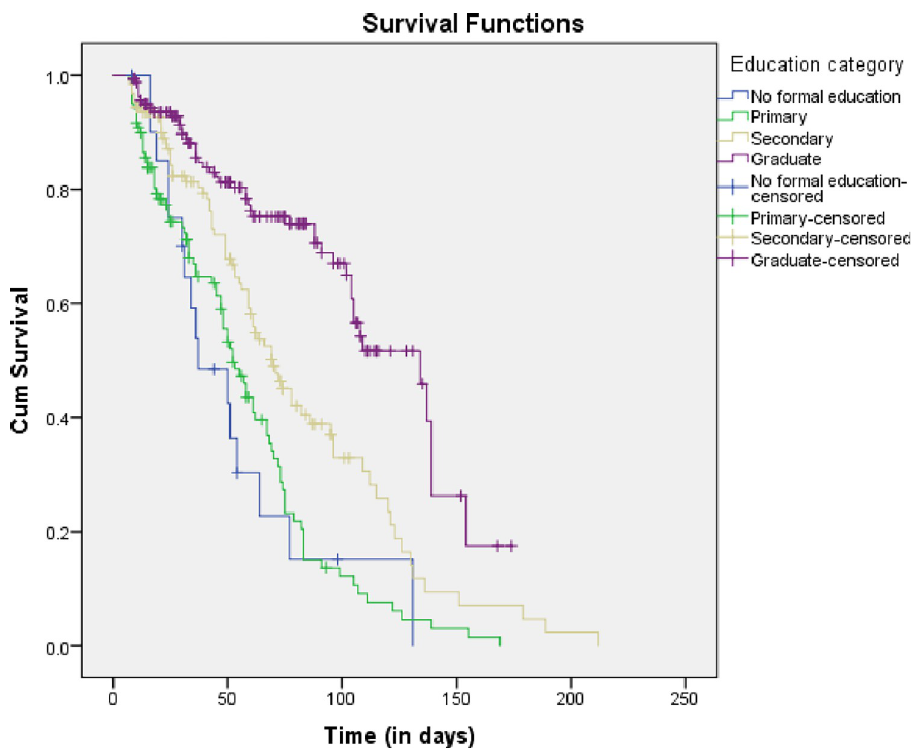
Fig 2. Kaplan-Meier survival estimate of educational status of women taking IFAS in Hosanna town, South Ethiopia, 2021.